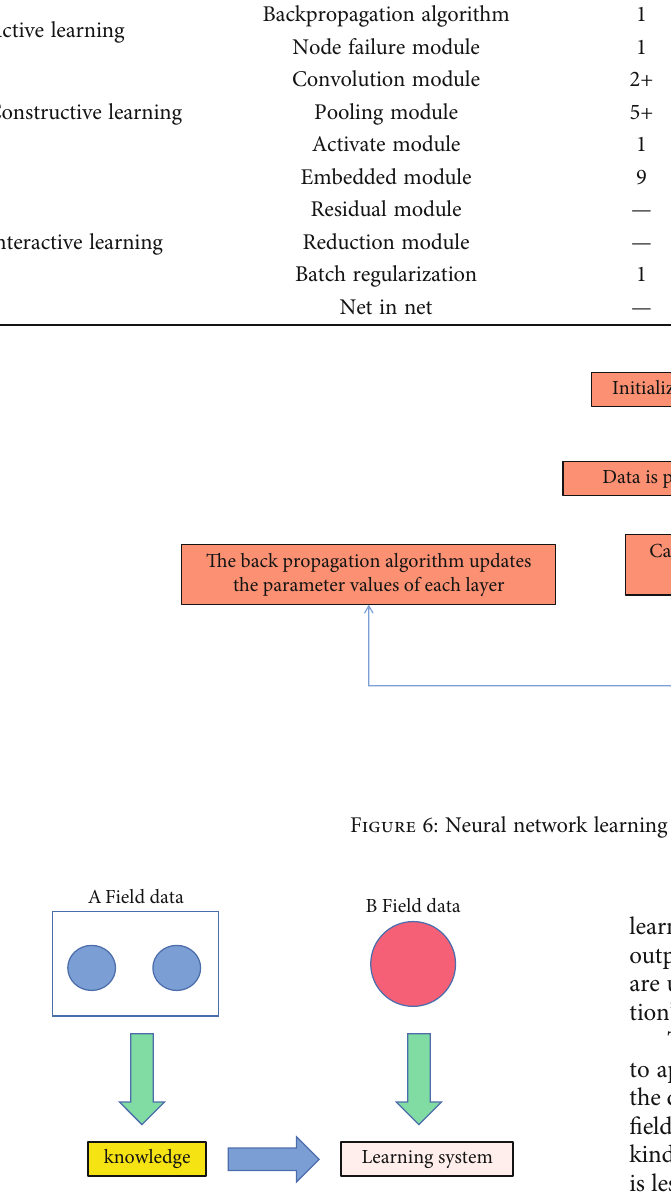
Figure 7: Transfer learning in neural network